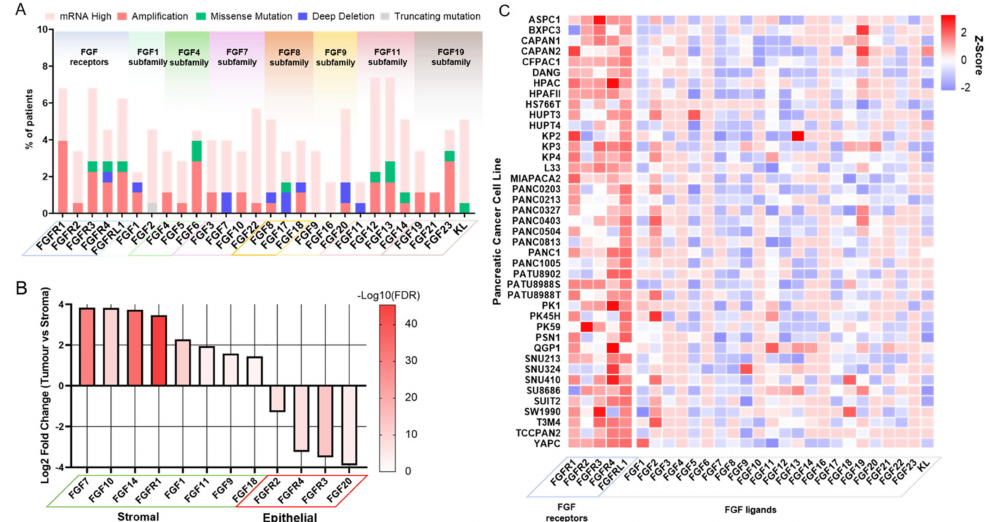
Figure 4. FGF/FGFR expression in PDAC patients and cell lines. ( A ) Mutation and expression data of FGF related genes from pancreatic tumours from TCGA cohort ( n = 177). Data of mutations and expression were generated using cBioPortal [58], where mRNA high was assigned to a Z-score > 2. ( B ) Significantly enriched FGF related genes from differential analysis results using DESeq2 [59] comparing microdissections of pancreatic tumour epithelial tissue compared to tumour stromal tissue. Positive Log2 fold change indicates higher expression in stromal tissue compared to tumour epithelial tissue and vice versa. The -Log10 transform of the false discovery rate (FDR) is used to show statistical significance. Data were obtained from GSE93326 [60]. ( C ) Gene expression heatmap of FGF related genes in pancreatic cancer cell lines from the Cancer Cell Line Encyclopaedia [61]. The Z-scores were calculated using the mean and standard deviation of all